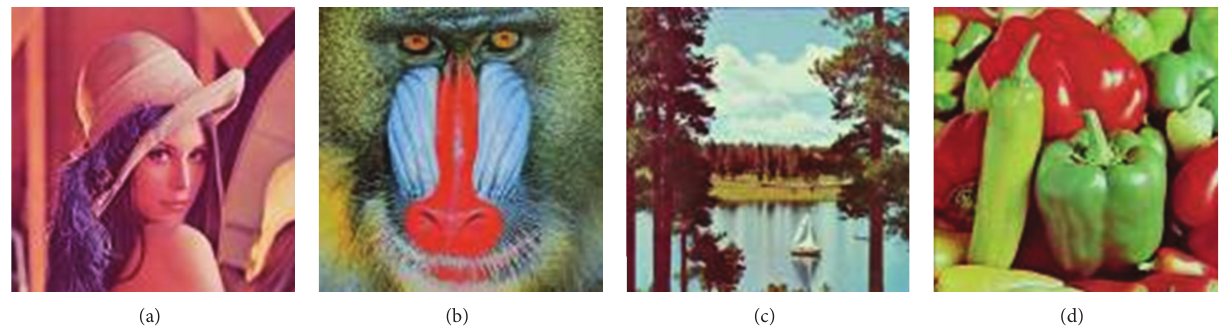
Figure 12: The test images used in the experiments: (a) Lena, (b) Mandrill, (c) Sailboat, and (d)